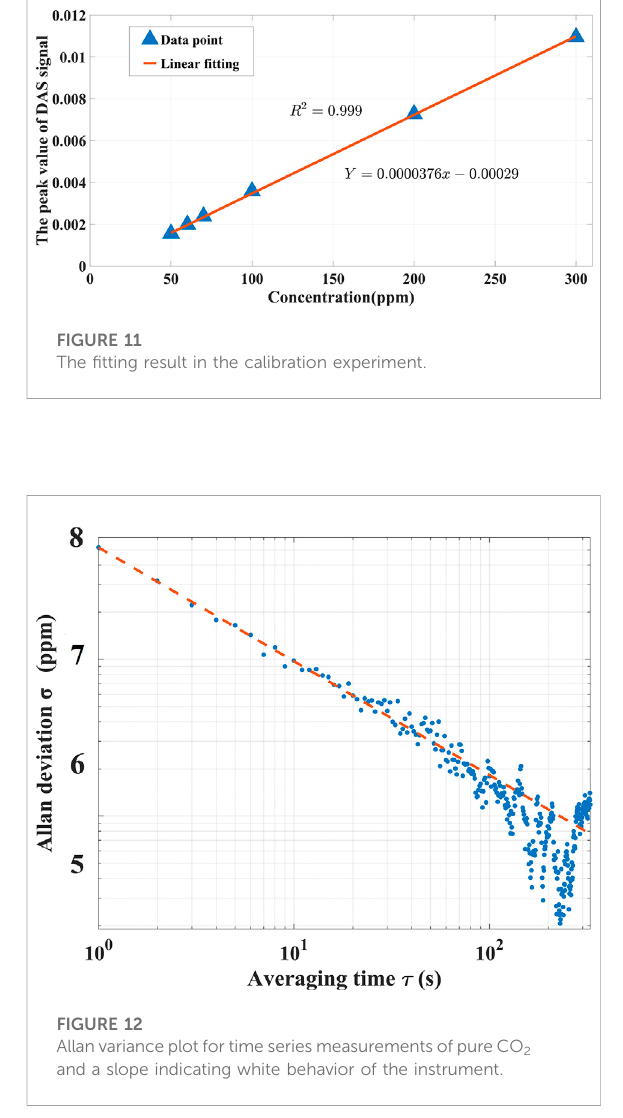
Figure 13 show the time series of the measured concentrations of 50 ppm CO 2 . The distribution histograms of deviations of the measured concentrations and the fi tting curve of the probability distribution are depicted in the lower panels of Figure 13. From these, the half-width at half maximum (HWHM) was calculated as 0.326 ppm. Thus, it was con fi rmed that the precision of system measurement was better than 0.65%. The measured concentration data obviously resembled a Gaussian distribution. These results verify that the system has excellent precision and stability.